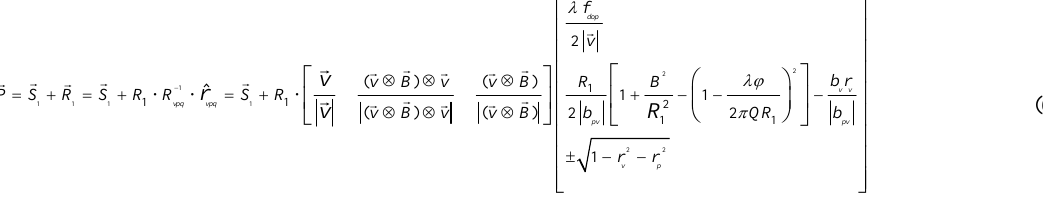
Figure 1. The geometrical relationship for spaceborne InSAR in topographic mapping